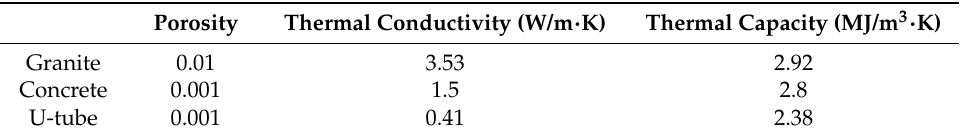
Figure 3. Simulation model. Table 1. Ground, borehole and U-tube properties.